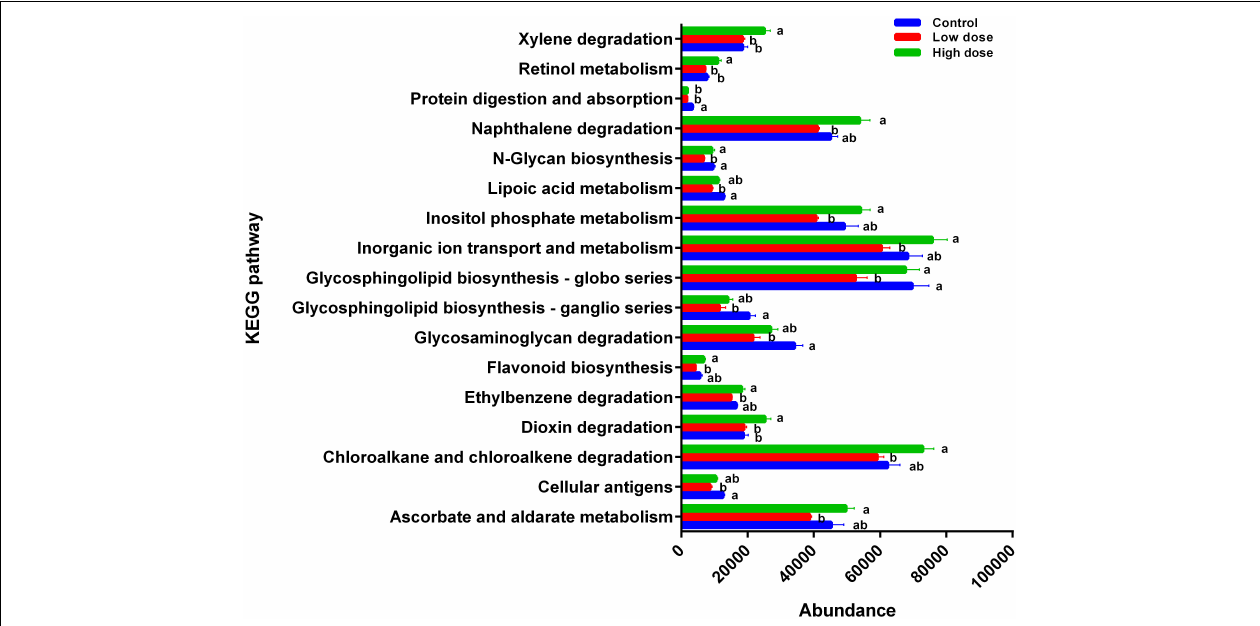
FIGURE 6 | Differences in the enrichment of various KEGG pathways among control group (0 mg/kg 6-MBOA), low 6-MBOA dose group (1 mg/kg 6-MBOA) and high 6-MBOA dose group (2 mg/kg 6-MBOA) in adult male Brandt’s vole. Error bars indicate standard errors. Same letters connect bars with no significant differences at P < 0.05 ( n =